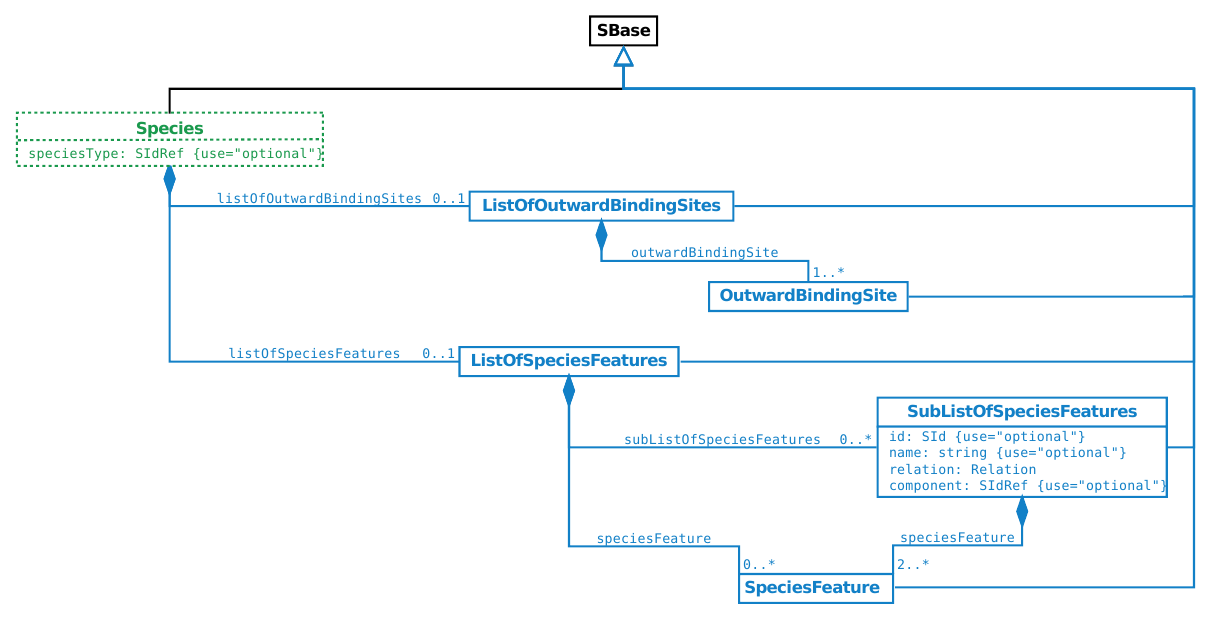
Figure 9: The extension of the Species